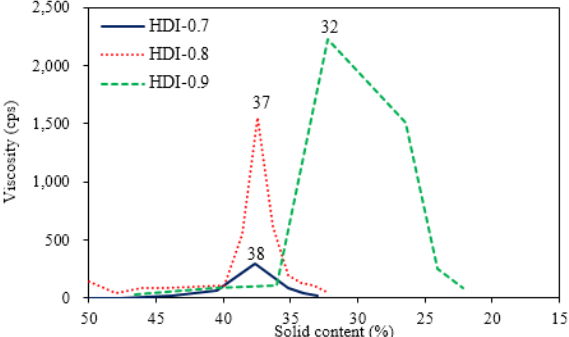
Figure 6. Viscosity variation of HDI ionomer dispersions with different NCO/OH mole ratios during the water dispersion process.